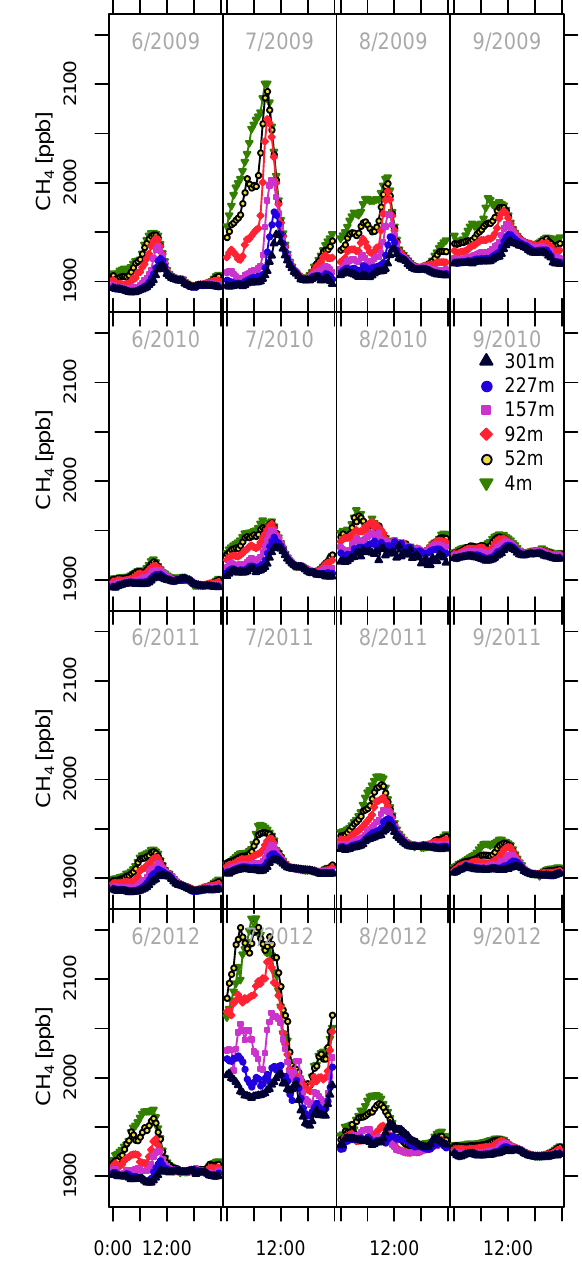
Fig. 3. CO 2 diurnal cycle, averaged for individual months and years.